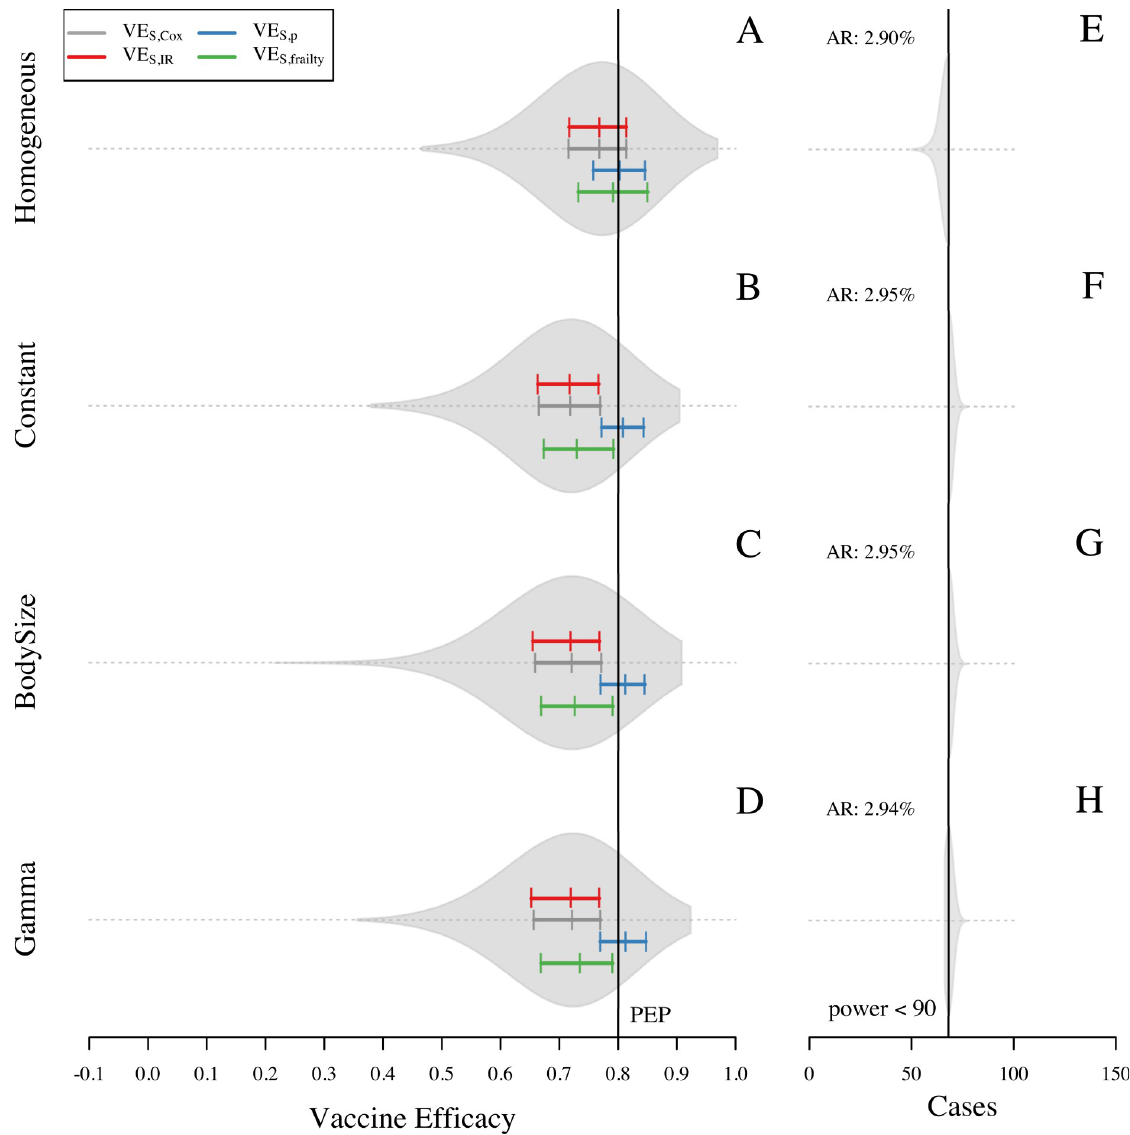
Fig 5. Vaccine efficacy in four scenarios about heterogeneous exposure to DENV for seropositive and seronegative individuals. Violin plots show the shape of the distribution of VE S,Cox estimates. The colored solid lines show the 25, 50, and 75 quantiles for VE S,Cox , VE S,p , VE S, IR , and VE S,frailty (gray, blue, red, and green, respectively). Black solid line represents the individual input of vaccine efficacy: VE = 1 –PEP = 1 —RR inf|exp RR dis|inf = 0.8. The left panel corresponds to VE S in seropositives and the right panel corresponds to the VE S in seronegatives.